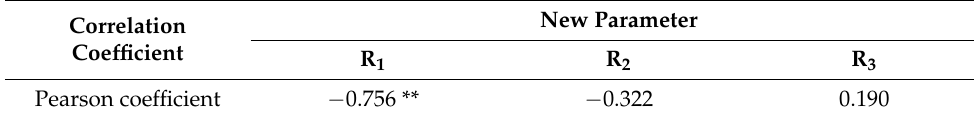
Table 6. Parameter correlation analysis.